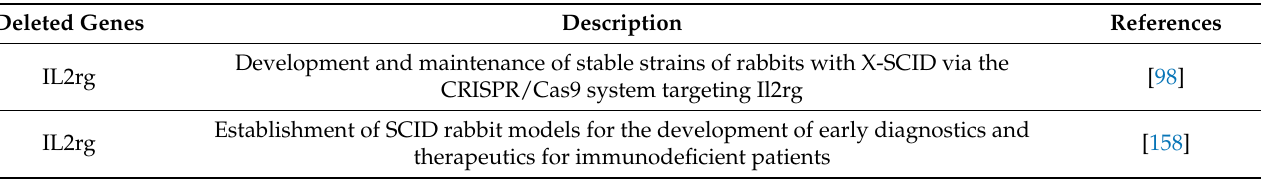
Table 2. Studies using SCID rabbit